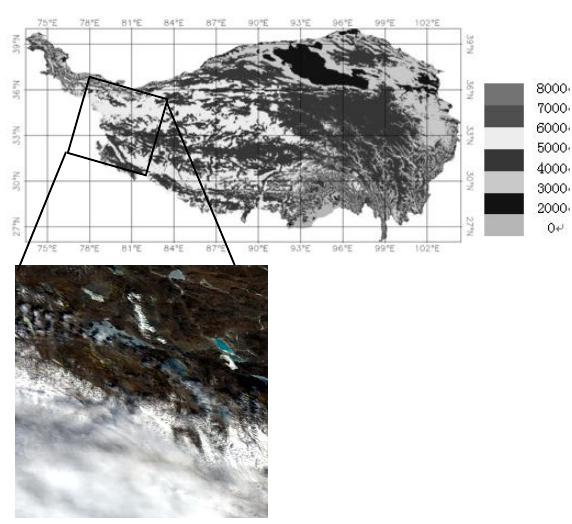
Figure2. The topographic map of the Tibetan Plateau from SRTM DEM data (Lina X.